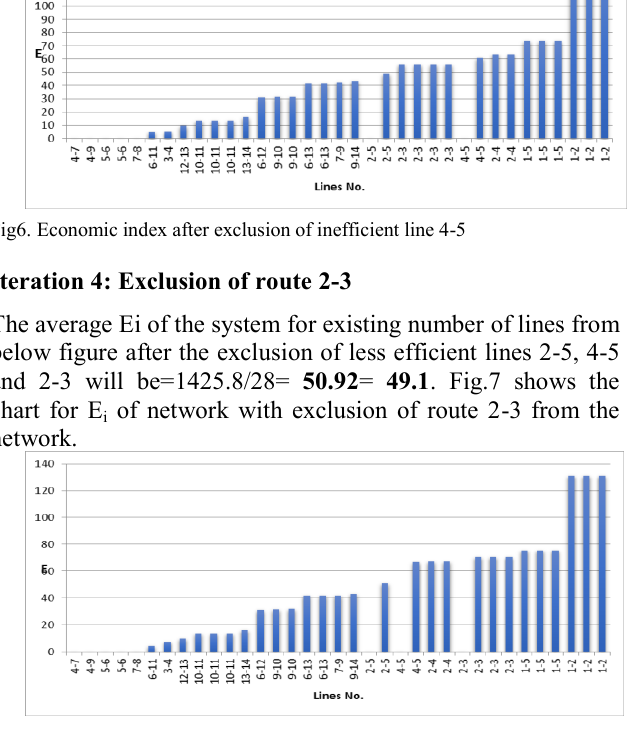
Fig4. Economic index with no exclusion of any alternate line Average